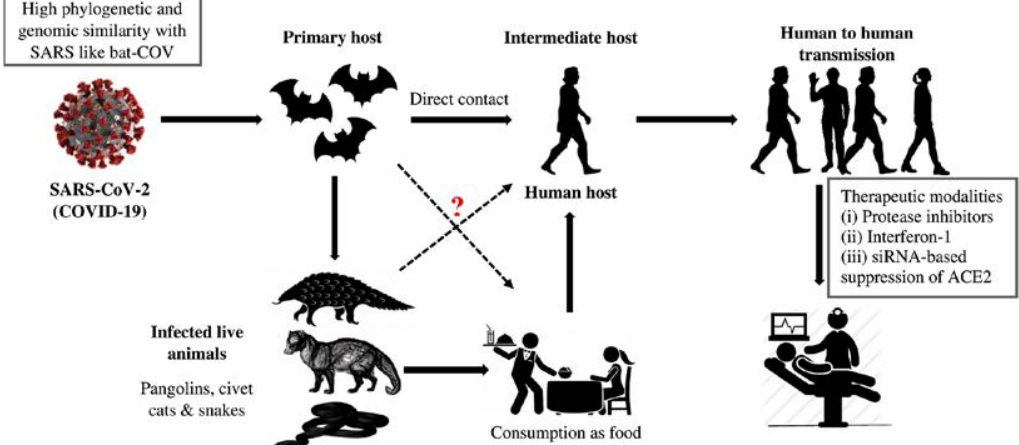
Fig.1. Source of infection and transmission of SARS-related coronaviruses to humans via intermediate